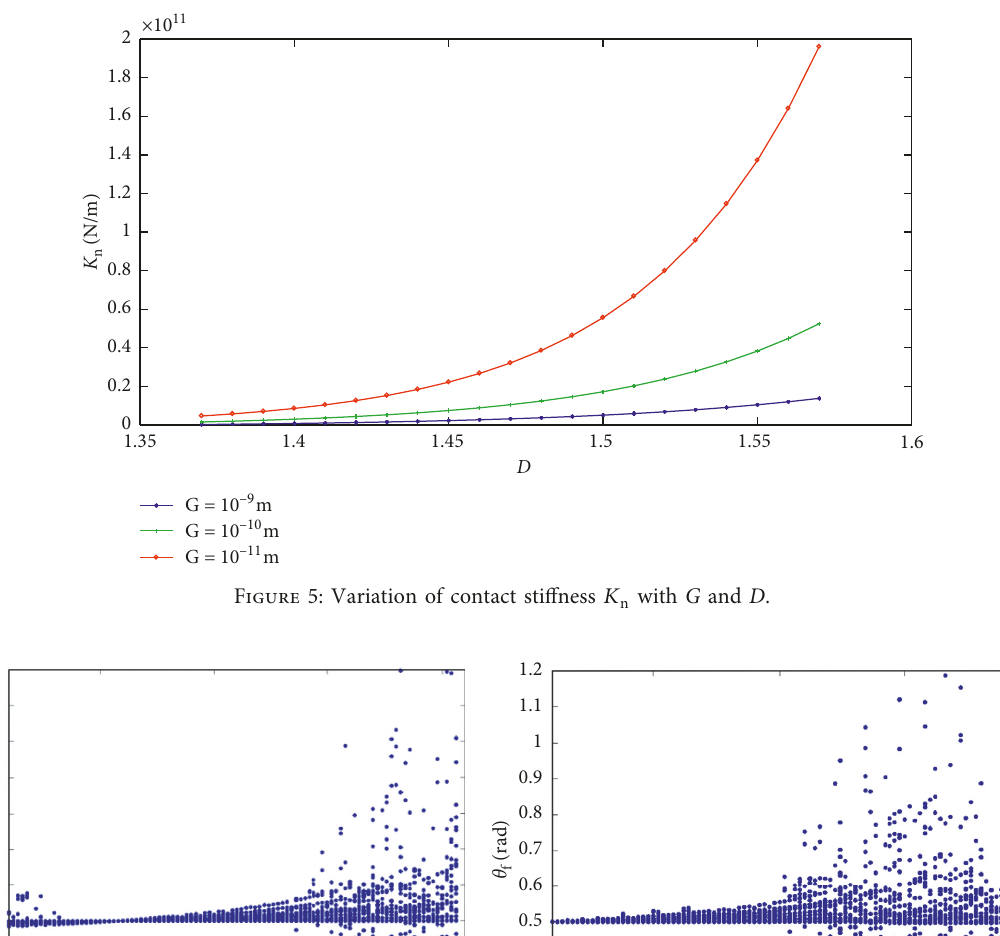
with D for different G . (a) G � 10 − 9 m. (b) G � 10 − 10 m. f